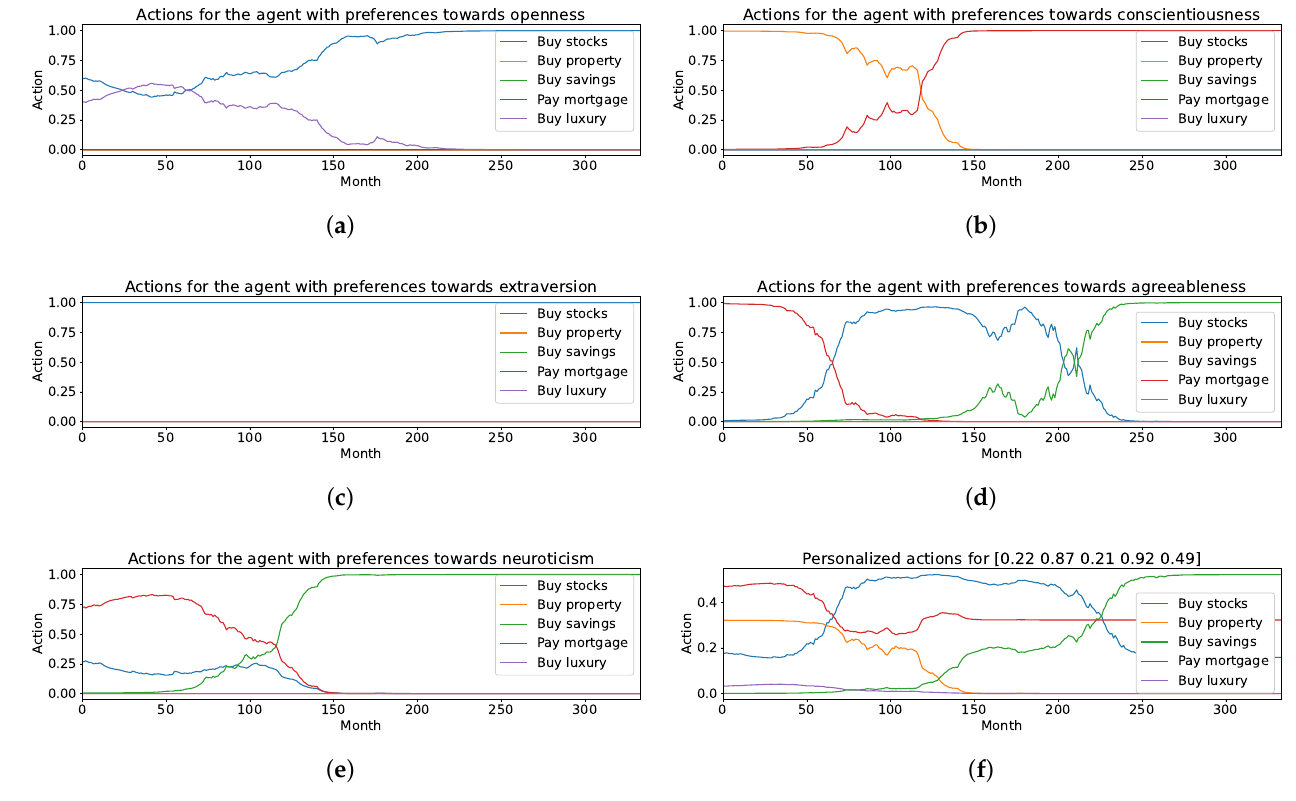
Figure 3. Investment strategies for different prototypical personality traits: ( a – e ) show the fractions of monthly investments for different assets. They reveal the distinct investment strategies with changing asset preferences for the five prototypical personality traits. In ( f ) we illustrate the investment strategy for a fictitious customer with a random personality profile [openness, conscientiousness, agreeableness, extraversion, and neuroticism] = [0.22, 0.87, 0.21, 0.92, 0.49]. The customer invests in a mixture of assets throughout the investment